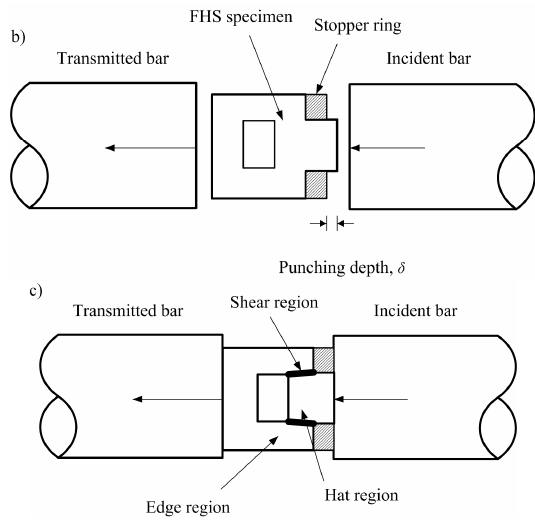
Figure 1. ( a ) In-plane dimensions of FHS specimen used in this study (dimensions in mm); ( b ) longitudinal section of FHS specimen, stopper ring, and dynamic testing configuration in SHPB